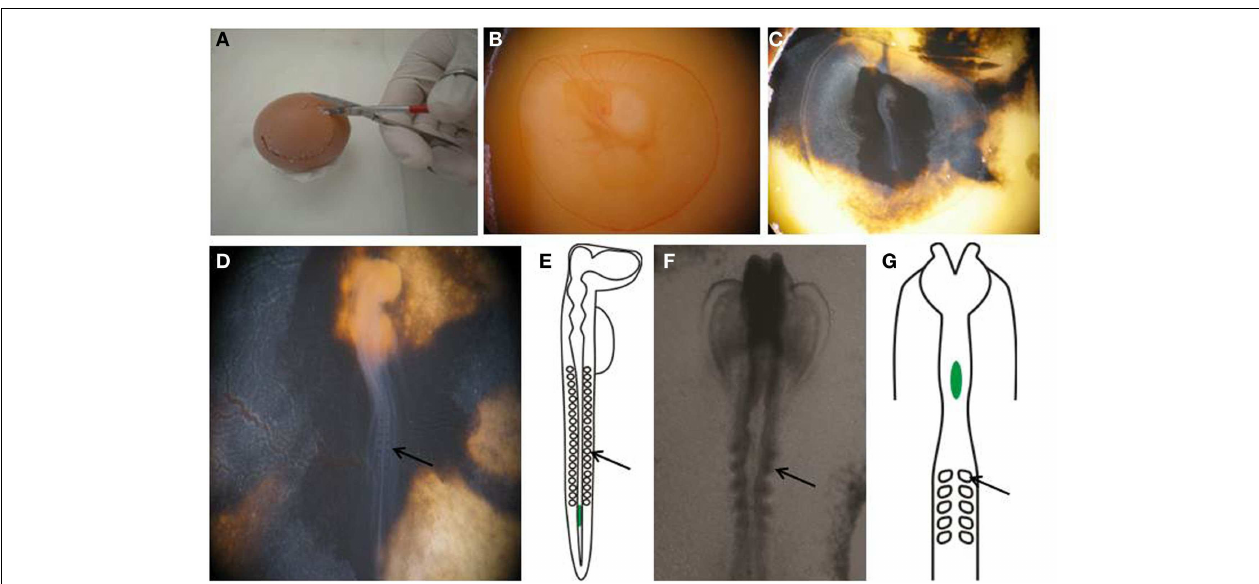
melanoma cells in green. (F) Wholemount view of the cranial region of an E1.5, or HH stage 8 + embryo. (G) Schematic of an E1.5/HH8 + embryo, showing the location of transplanted melanoma cells in green. Arrows point to somites.